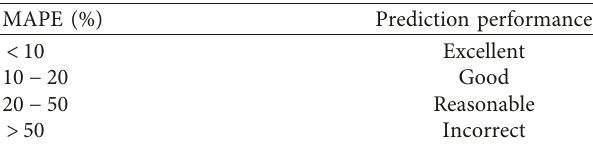
Table 3: Lewis’ criterion for model evaluation.